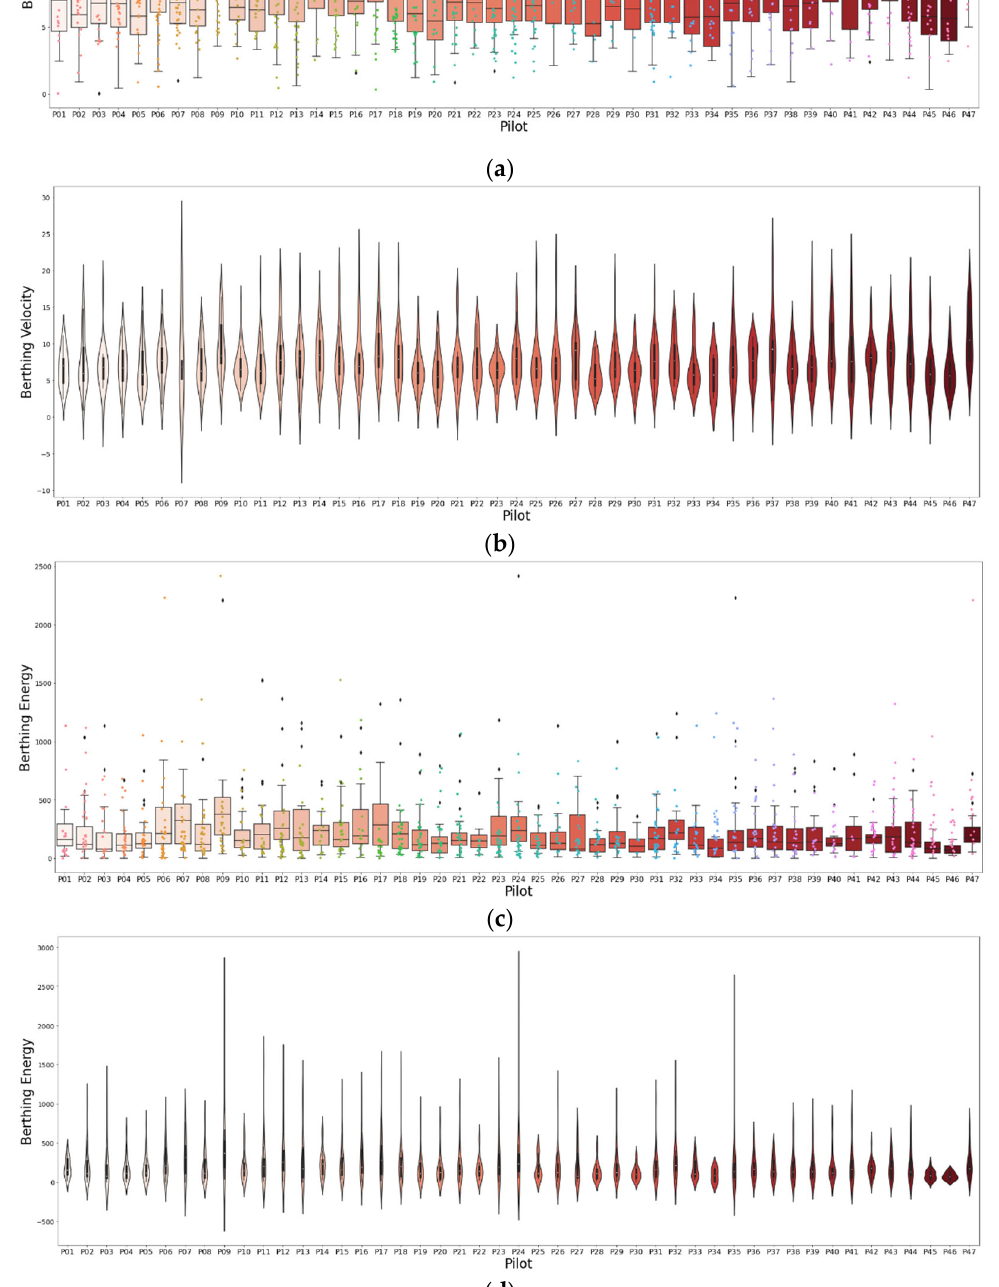
Figure 8. Mean and standard deviation of berthing velocity and energy for each pilot in the order of pilot ID. The mean is shown in a boxplot, and the standard deviation is shown in a violin plot to make it easy to visualize the degree of deviation. ( a ) Boxplot of berthing velocity mean; ( b ) violin plot of berthing velocity standard deviation; ( c ) boxplot of berthing energy mean; ( d ) violin plot of berthing energy standard deviation .